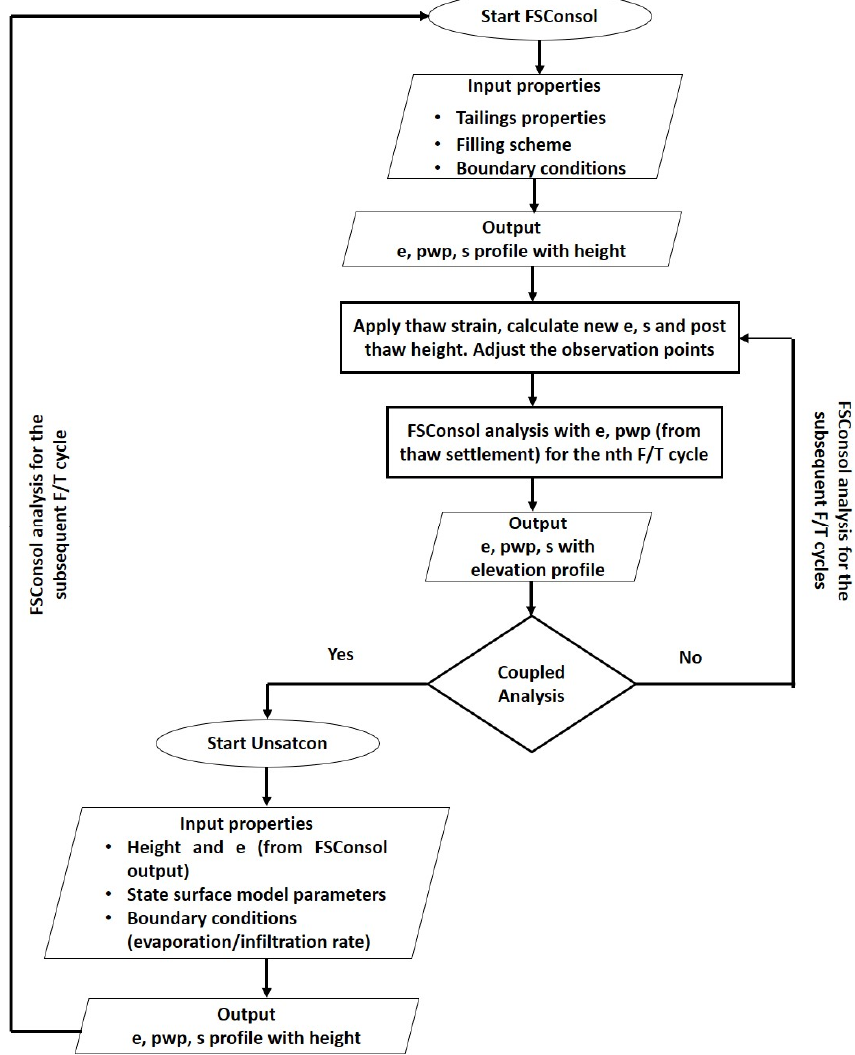
Figure 3. Flowchart diagram of coupling analysis.